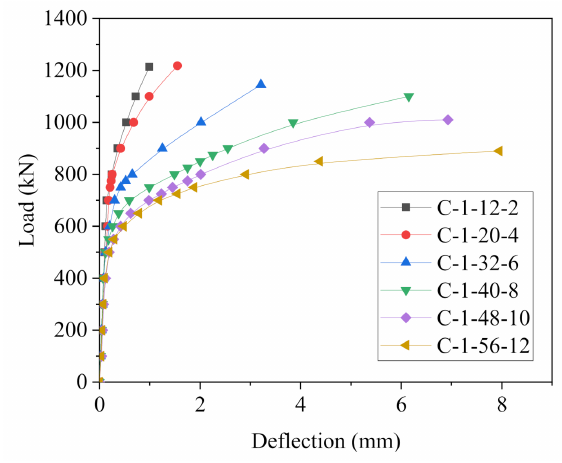
Figure 4. Load vs. deflection